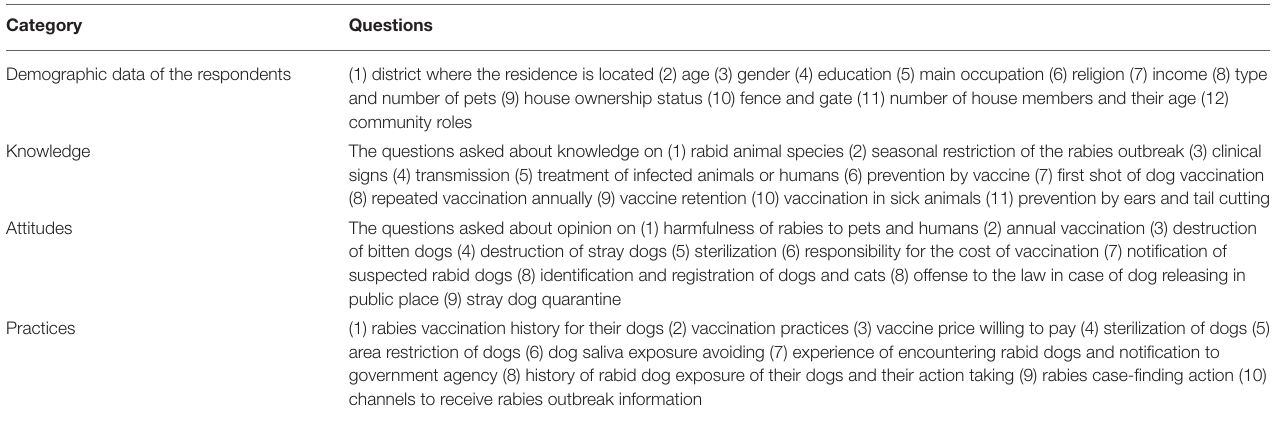
TABLE 1 | Overview of the KAP